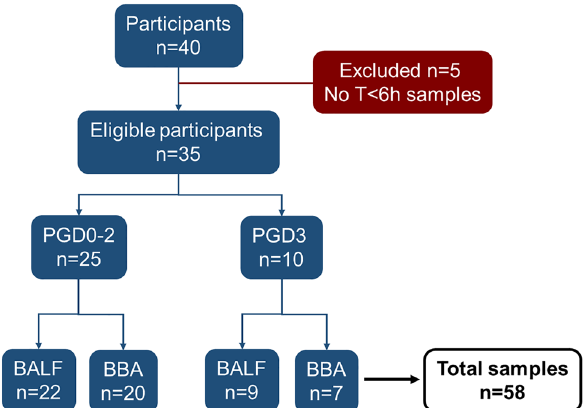
Figure 1. Flow chart of patient population according to Standards for Reporting of Diagnostic Accuracy (STARD) guidelines 26 .